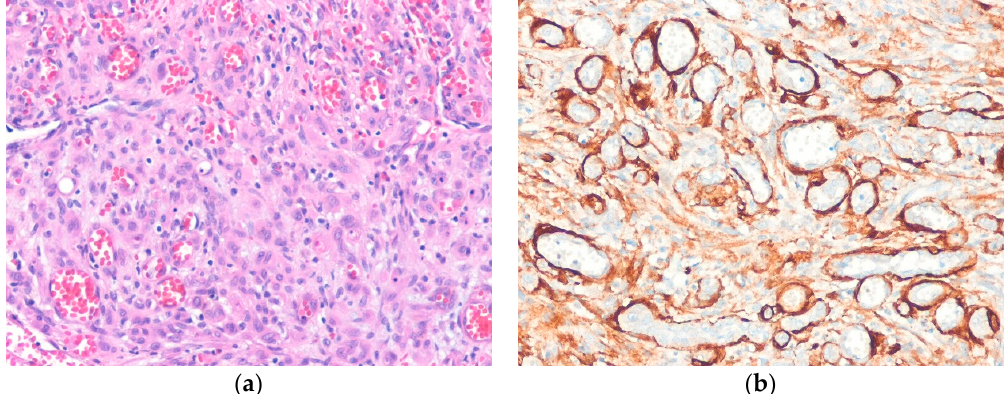
Figure 2. Cellular epithelioid hemangioma. ( a ) The tumor shows epithelioid endothelial cells with a solid pattern; ( b ) Immunostaining for smooth muscle actin highlights pericytes and well-formed blood vessels (H&E stain, original magnification 200× ( a ); SMA immunostain, original magnification 200× ( b )).